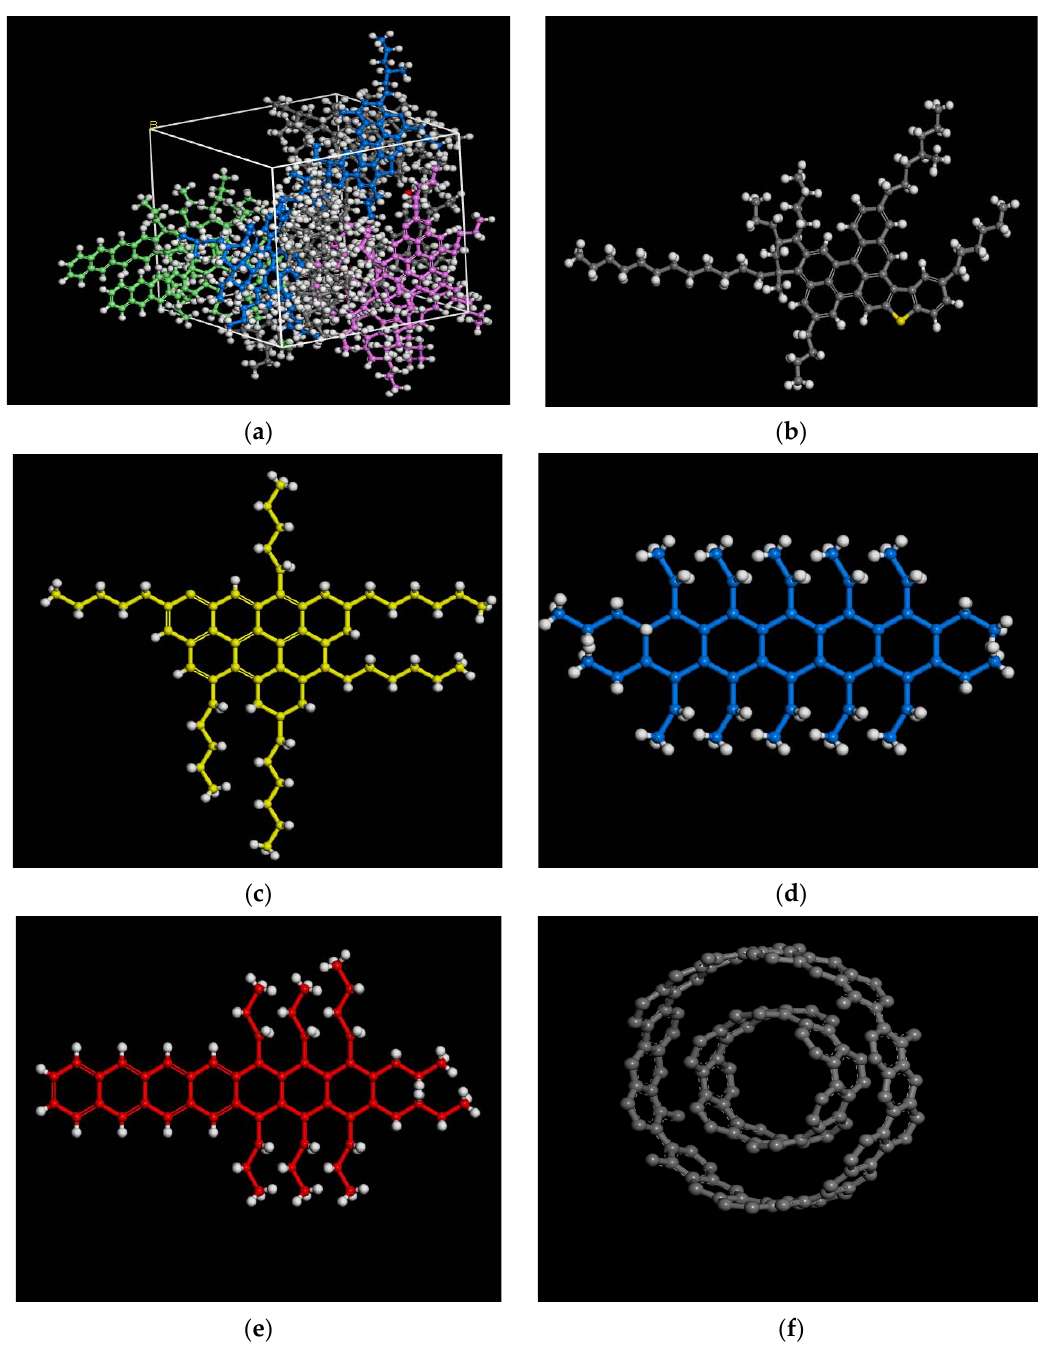
Figure 1. Molecular models of MWCNTs ‐ MA: ( a ) asphalt ‐ binder; ( b ) asphaltenes; ( c ) resins; ( d ) saturates; ( e ) aromatics; and ( f ) MWCNTs.